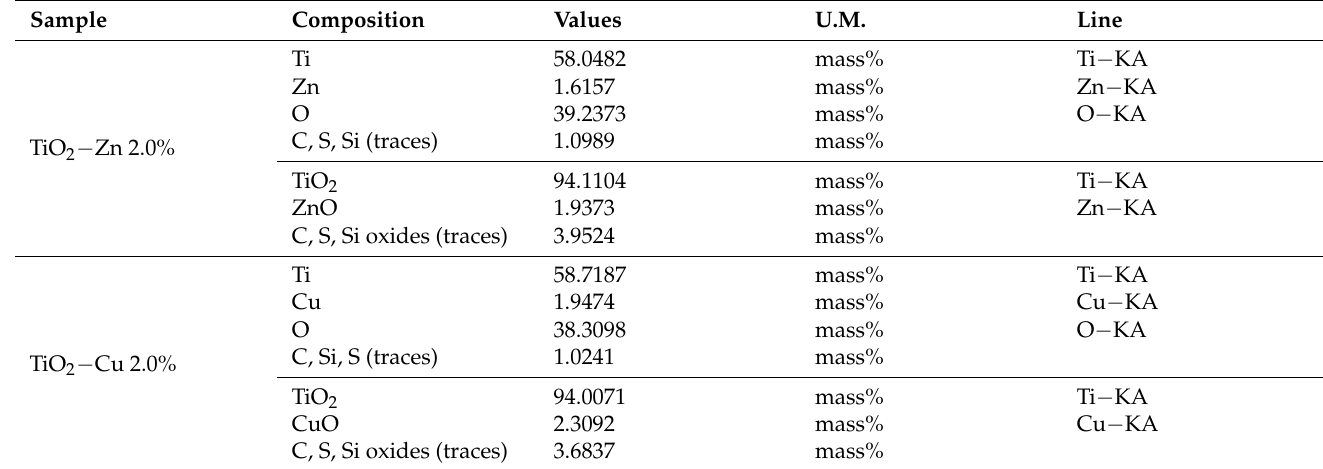
Table 3. XRF results of the analysed